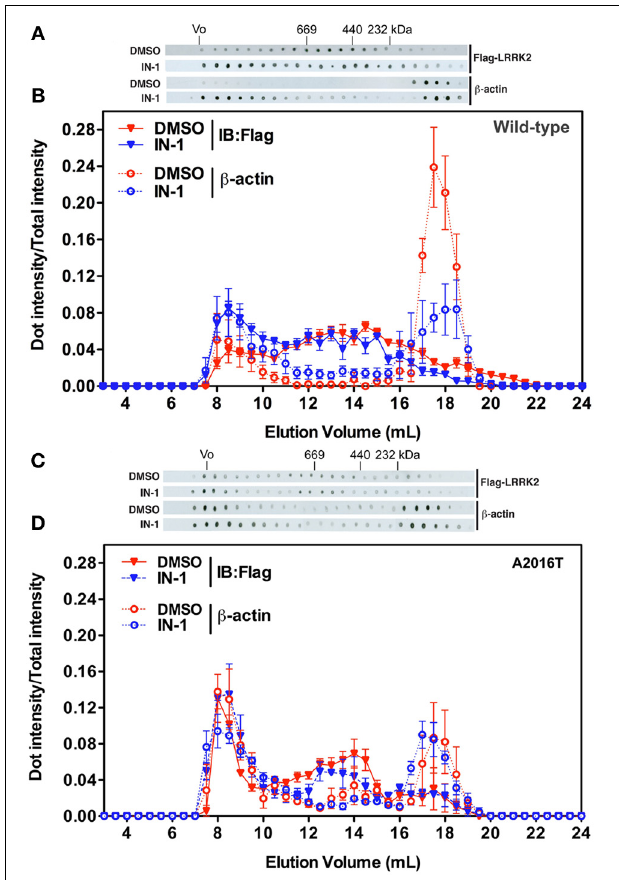
FIGURE 6 | IN-1 alters LRRK2 macromolecular complex. (A) HEK293T cells expressing FLAG-LRRK2 wild-type were treated or not with IN-1 (1 µ M, 90min), solubilized and then separated by SEC. FLAG-LRRK2 and actin were revealed by western-blotting of fractions spotted on nitrocellulose. (B) The intensity of each dot (fraction) is normalized by the integrated intensities. (C) HEK293T cells expressing FLAG-LRRK2 A2016T were treated or not with IN-1 (1 µ M, 90min), solubilized and then separated by SEC. LRRK2 and actin were revealed by western-blotting of fractions spotted on nitrocellulose. (D) The intensity of each dot (fraction) is normalized by the integrated intensities.